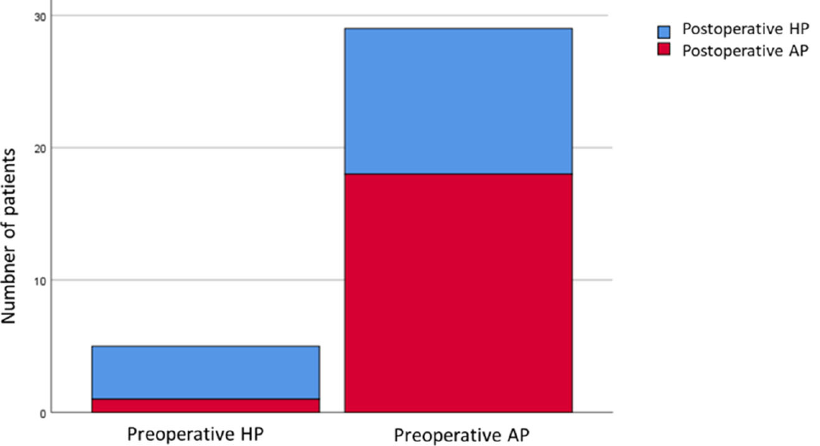
Figure 3. Distribution of apnea/hypopnea predominance in non-responders. AP, apnea-predominant; HP, hypopnea ‐ predominant.